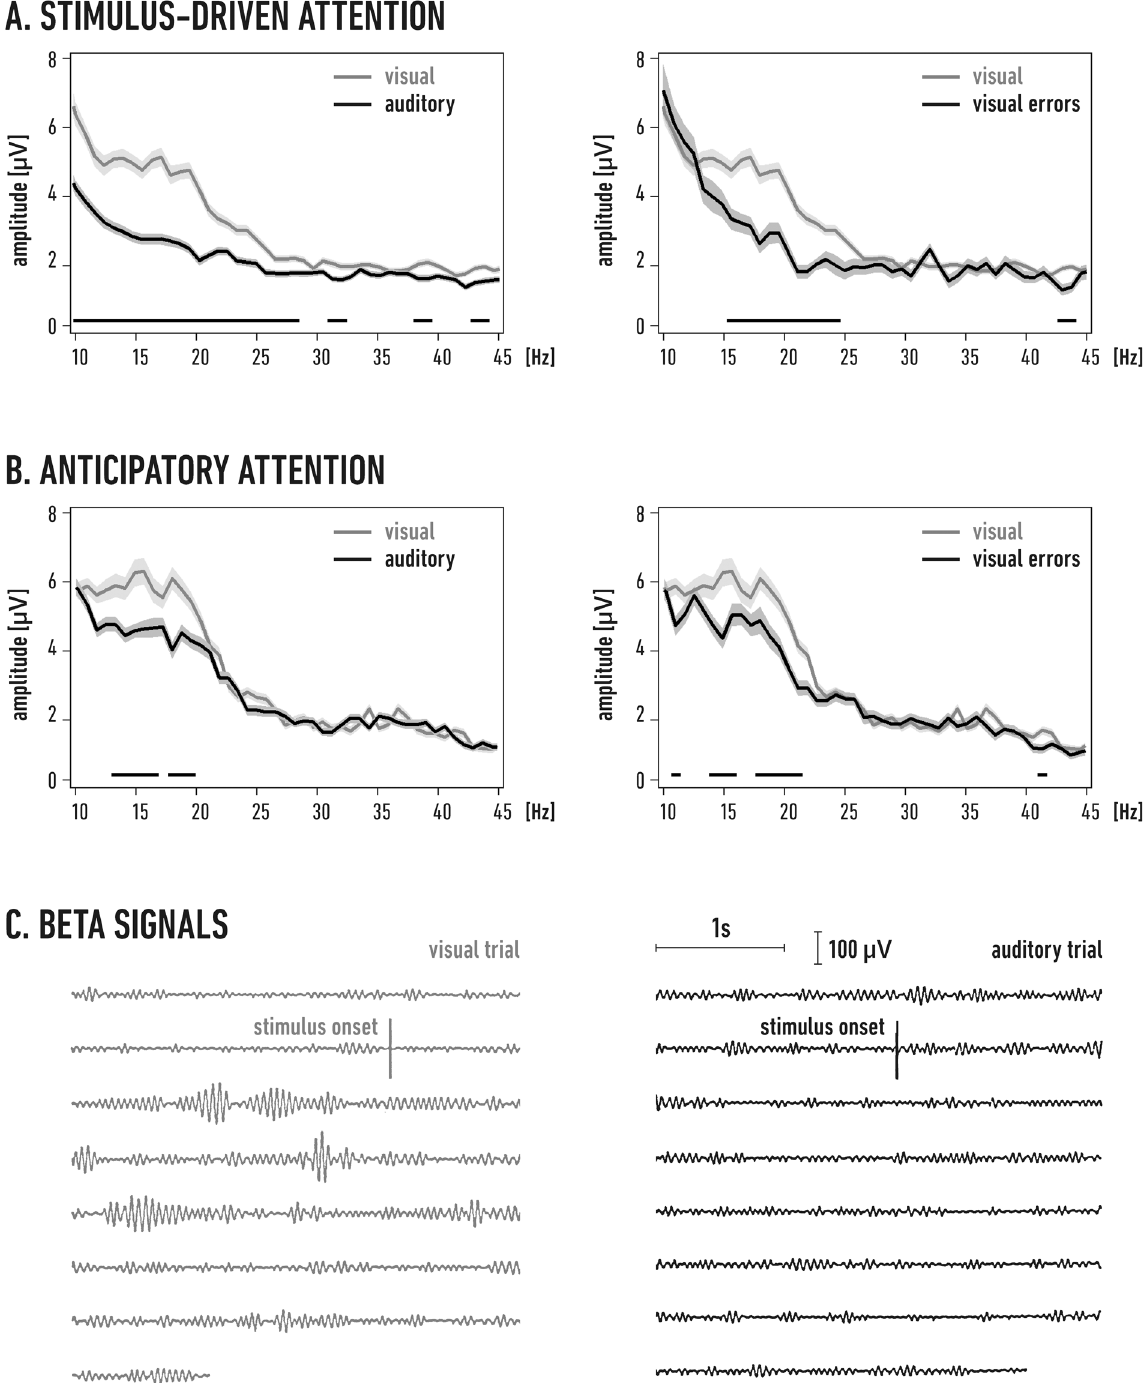
Fig 2. Beta activity increases in the primary visual cortex during attention trials. A. Stimulus-driven paradigm (cat B, Cx 17/1, see Table 1). Left: mean FFT spectra obtained from all correct trials during the three experimental days after the behavioral criterion was reached. The visual (gray) and auditory (black) means were obtained by averaging respectively 820 and 760 spectra of 1.28 s long data epochs (see Methods for details). Right: comparison of the mean spectrum from the correct visual trials (gray; same as in the left panel) with the mean FFT from 90 epochs from incorrect trials (black). B. Anticipatory paradigm (cat E, Cx 17/2). The recorded signals were subjected to the same analysis as in A. Means were obtained from 748 and 765 spectra for correspondingly correct visual and correct auditory trials, and from 320 spectra for incorrect visual trials. In A and B, the shading around the FFT spectra indicates the SEM. The lines above the horizontal axes denote the frequencies at which significant differences were found between the spectra from the